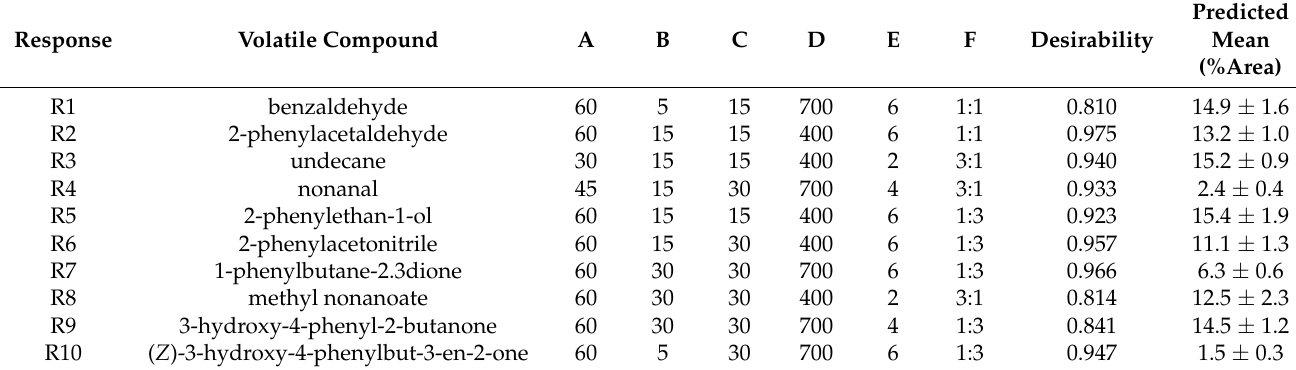
Table 5. Optimum conditions, desirabilities, and predicted mean for each response.